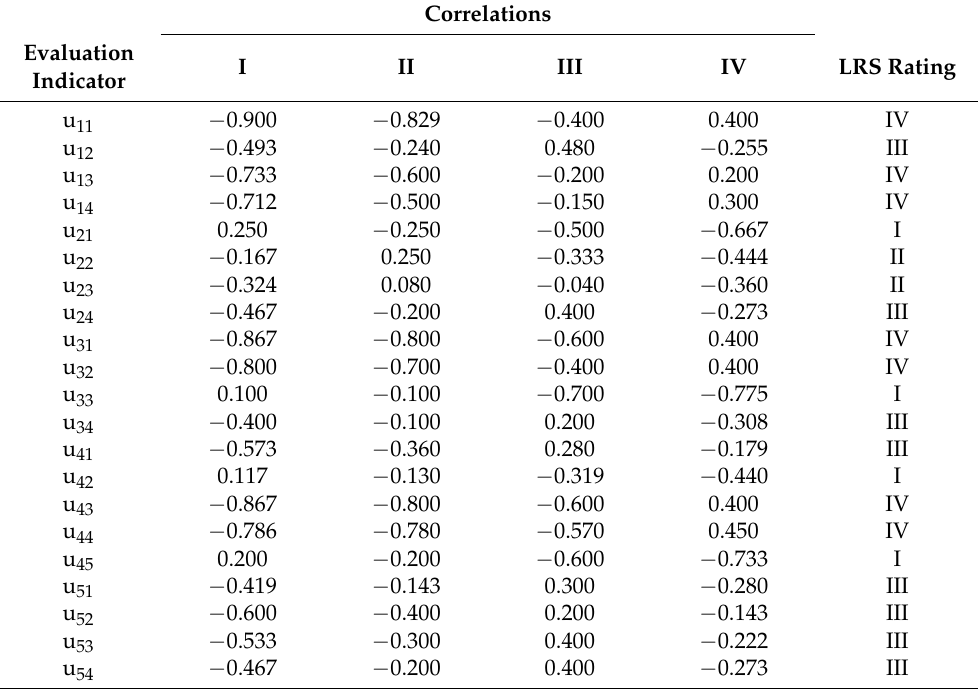
Table 15. Correlation matrix of each evaluation indicator at the indicator